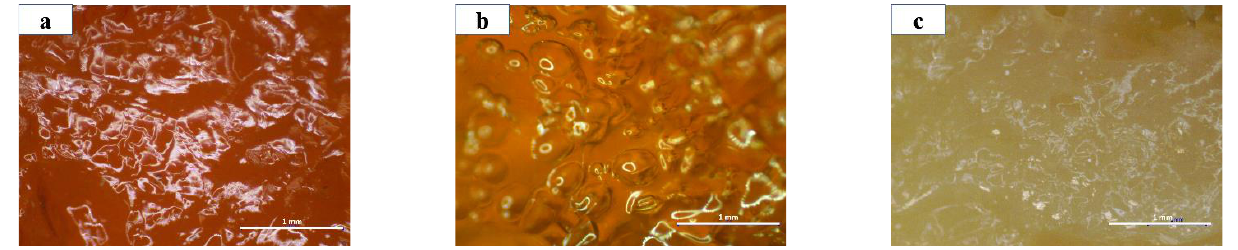
Figure 2. The surface images of CS/gel/mineral porous gel of ( a ) 1MCG; ( b ) 1ZCG; and ( c ) 1TCG.